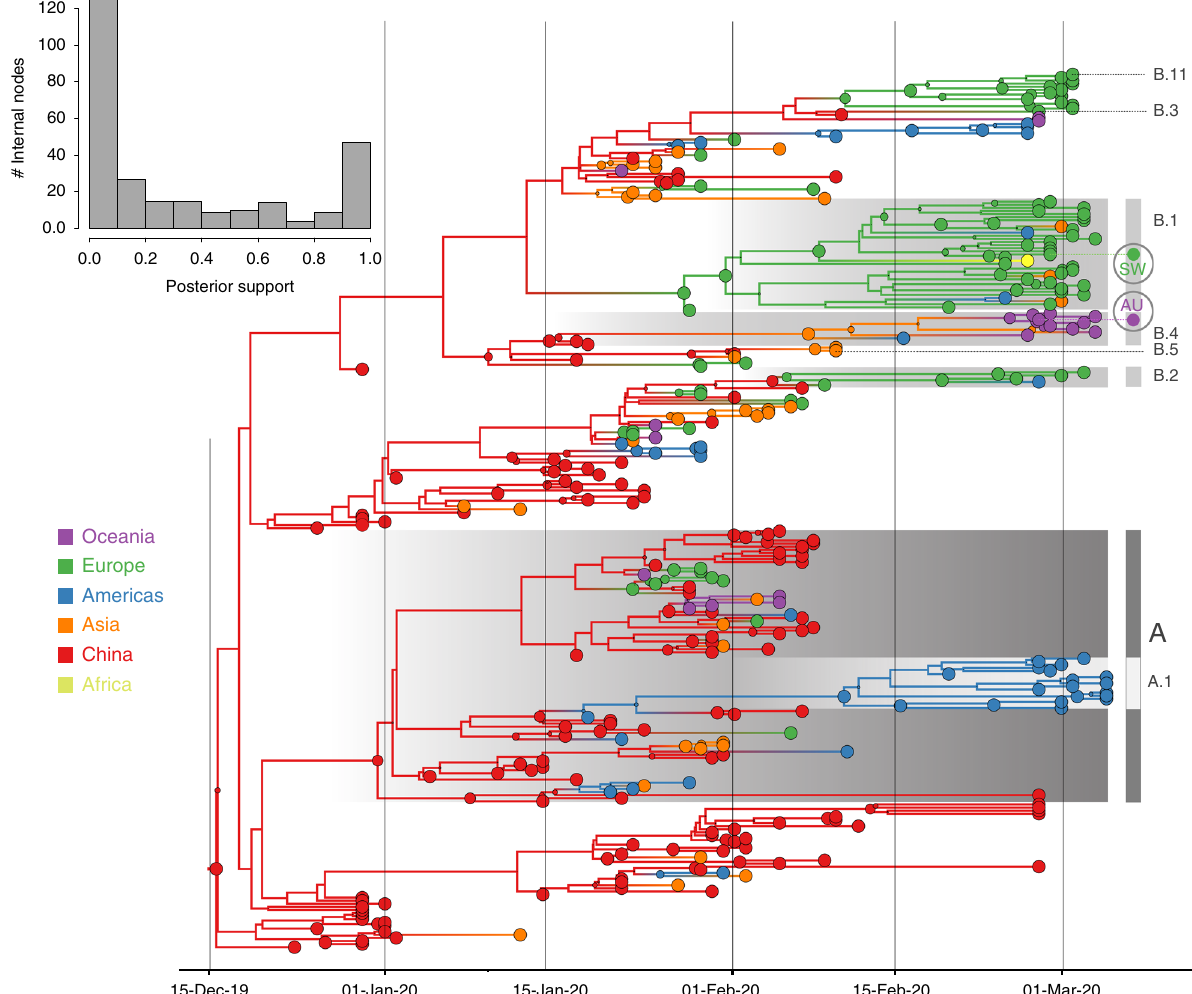
Fig. 1 Bayesian phylogeographic reconstruction for the full data set incorporating travel history data. Although the phylogeographic analysis was performed using 44 location states, nodes and branches are shaded according to an aggregated color scheme for clarity. Lineage classi fi cations are highlighted for speci fi c clusters: lineage A is embedded in lineage B. For lineage B, only speci fi c sub-lineages are indicated. The taxa from Switzerland (SW) and Australia (AU) further investigated using trajectory plots are indicated at the tips of the trees. The inset represents a histogram of the internal node posterior support